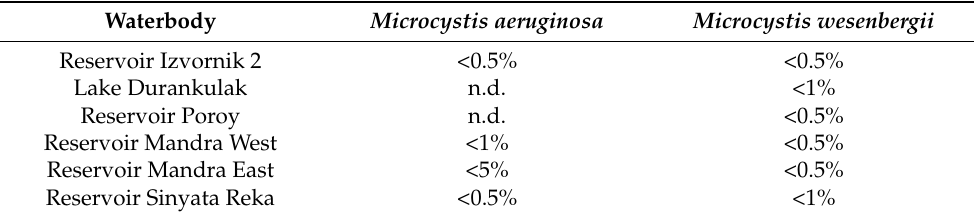
Table 2. Distribution of Microcystis taxa in the studied Bulgarian waterbodies (August 2019) with their contribution to the total phytoplankton biomass (n.d.—not detected).